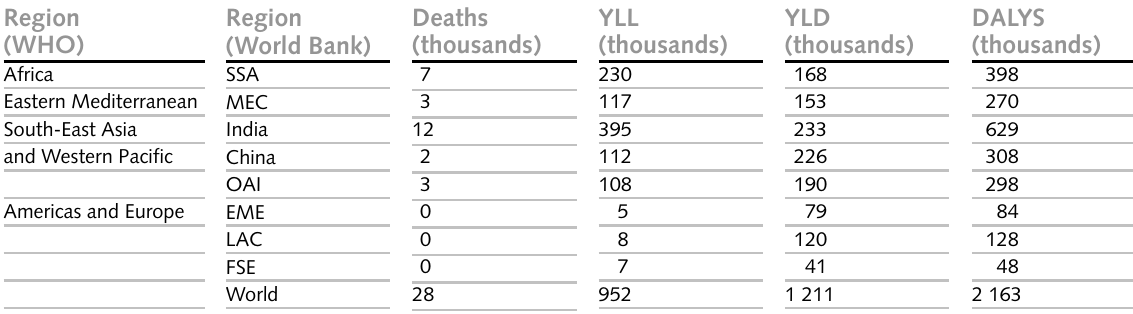
Table 7. Deaths, years of life lost ( YLL ), years lived with disability ( YLD ), and DALY s from otitis media, by